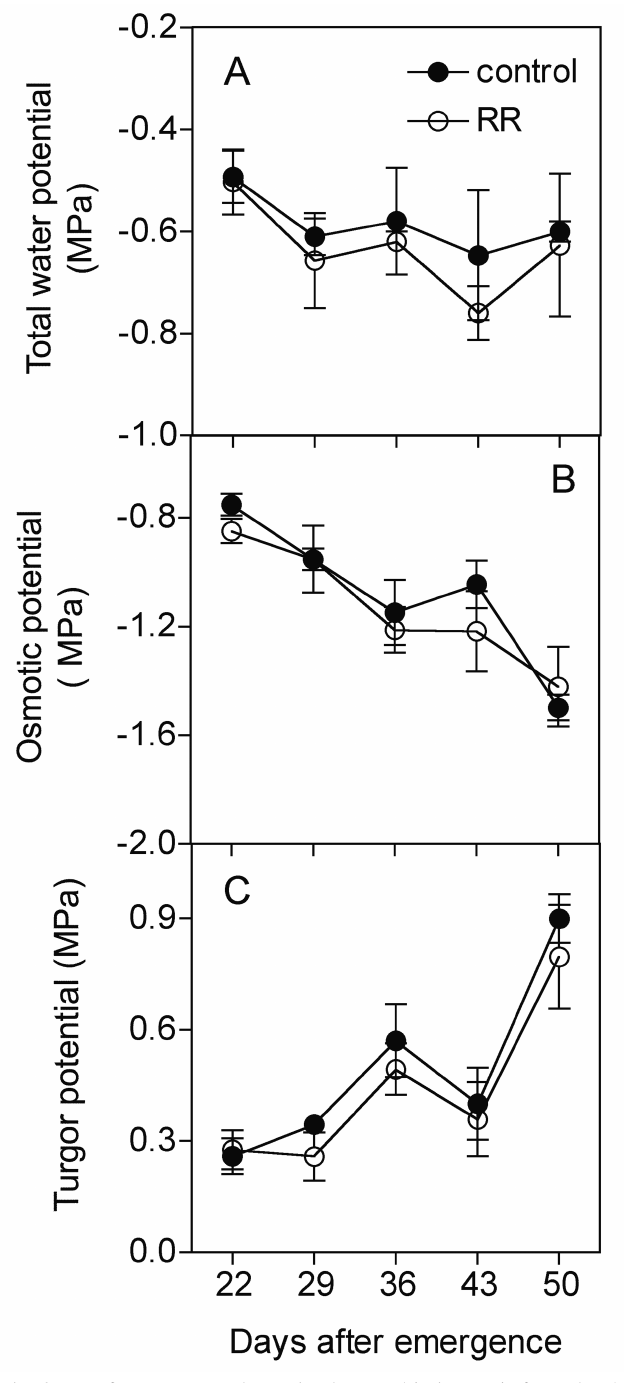
Fig. 3 - Leaf water status determined at weekly intervals from day 22 to the end of the experiment in both control and root-restricted (RR) plants: total water potential (A), osmotic potential (B) and turgor (C). * indicates significantly different values for P≤0.05 (n=5), when means were separated by Duncan’s